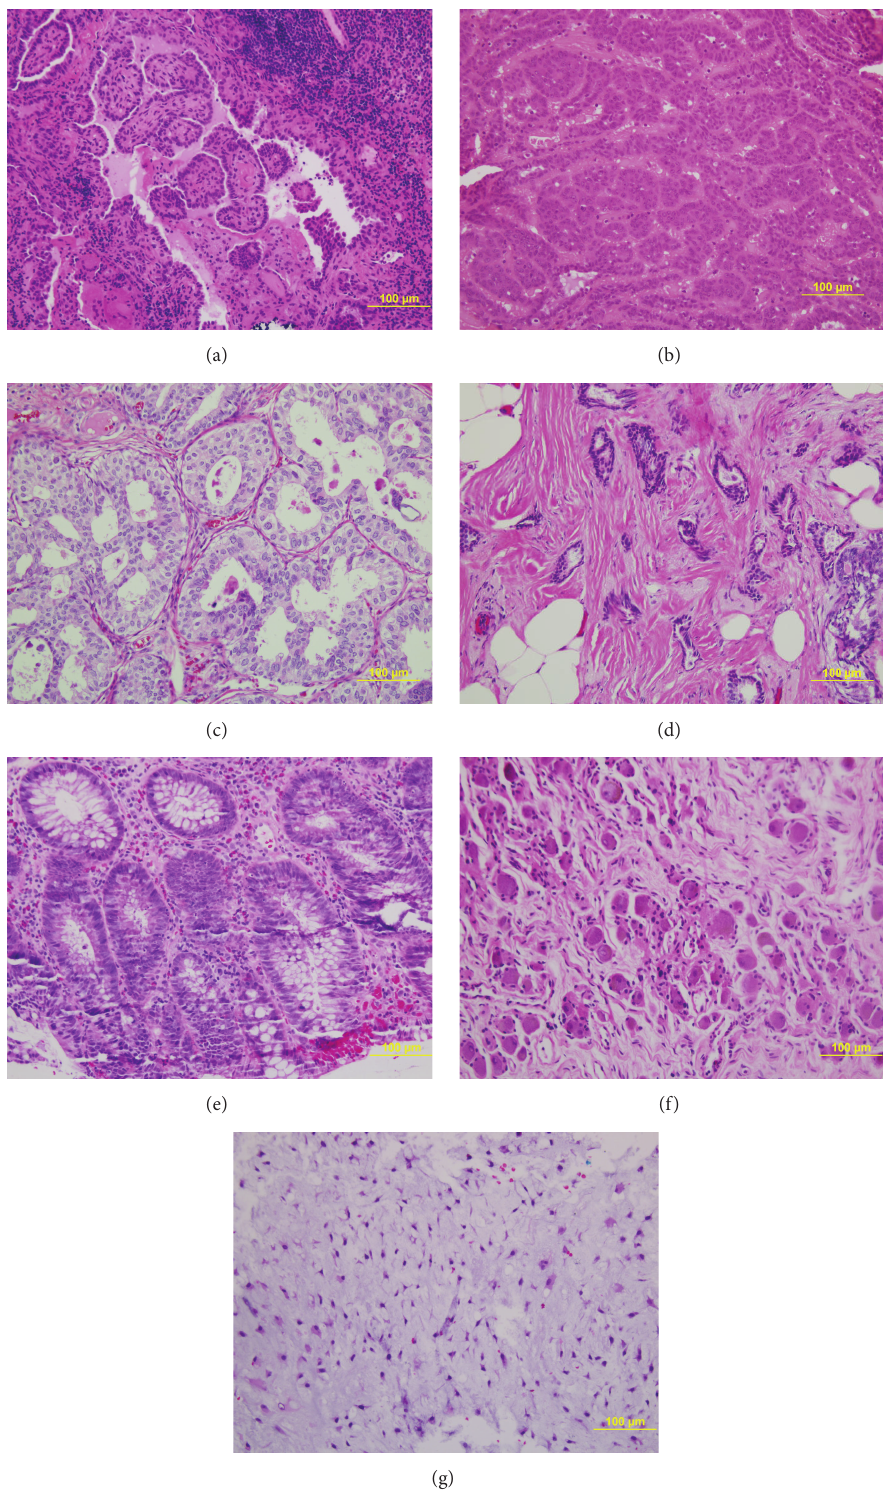
Figure 1: Malignant and benign lesions in the case. (a) Lymph node: metastatic papillary thyroid carcinoma in lymph node (H&E stain, × 200 original magnification, bar = 100 micrometers). (b) Kidney: renal cell carcinoma (H&E stain, × 200 original magnification, bar = 100 micrometers). (c) Breast: ductal carcinoma in situ (H&E stain, × 200 original magnification, bar = 100 micrometers). (d) Breast: invasive ductal carcinoma(H&Estain, × 200originalmagnification,bar=100micrometers).(e)Colon:tubularadenomatouspolyp(H&Estain, × 200original magnification, bar = 100 micrometers). (f) Paratrachea: ganglioneuroma (H&E stain, × 200 original magnification, bar = 100 micrometers). (g) Chest wall: chondrosarcoma (H&E stain, × 200 original magnification, bar = 100